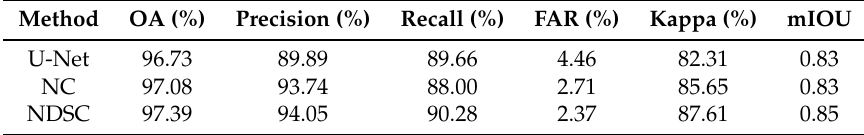
Table 2. Evaluation results with U-Net, NC, and NDSC models on the test dataset.